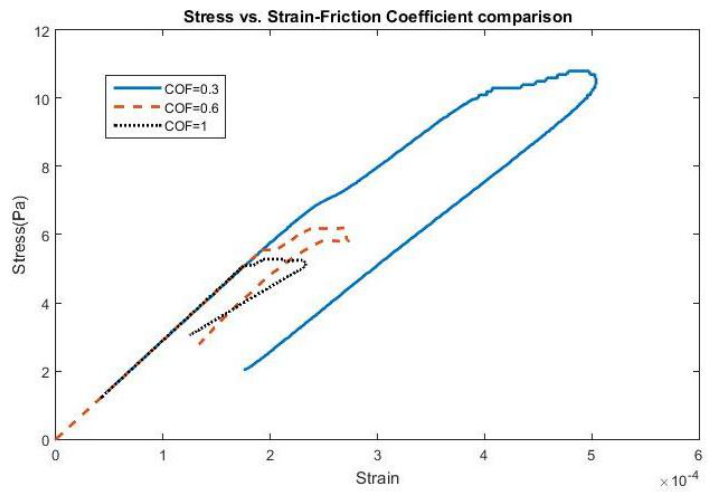
Figure 2. Stress vs. Strain for a 4-micron amplitude at 40 Hz using various COFs.